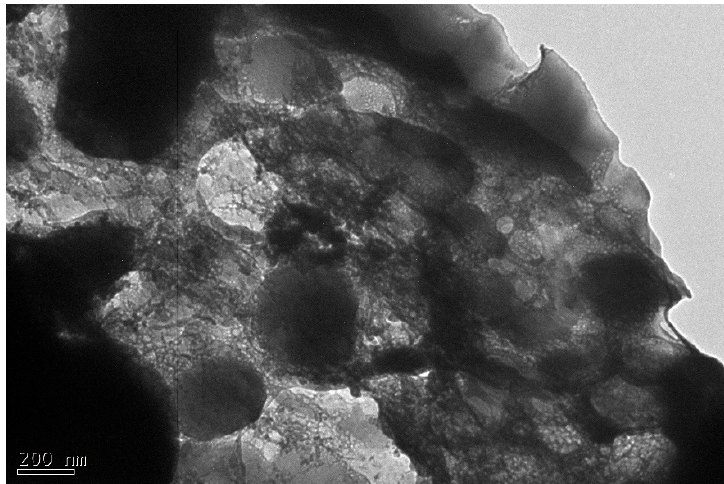
Figure 4. TEM image of the 4 layered Ni 50.3 Ti/Ni 49.6 Ti composite.